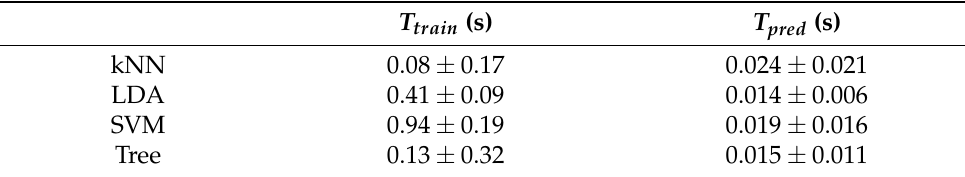
Table 2. Time to train the proposed approaches and infer a prediction.